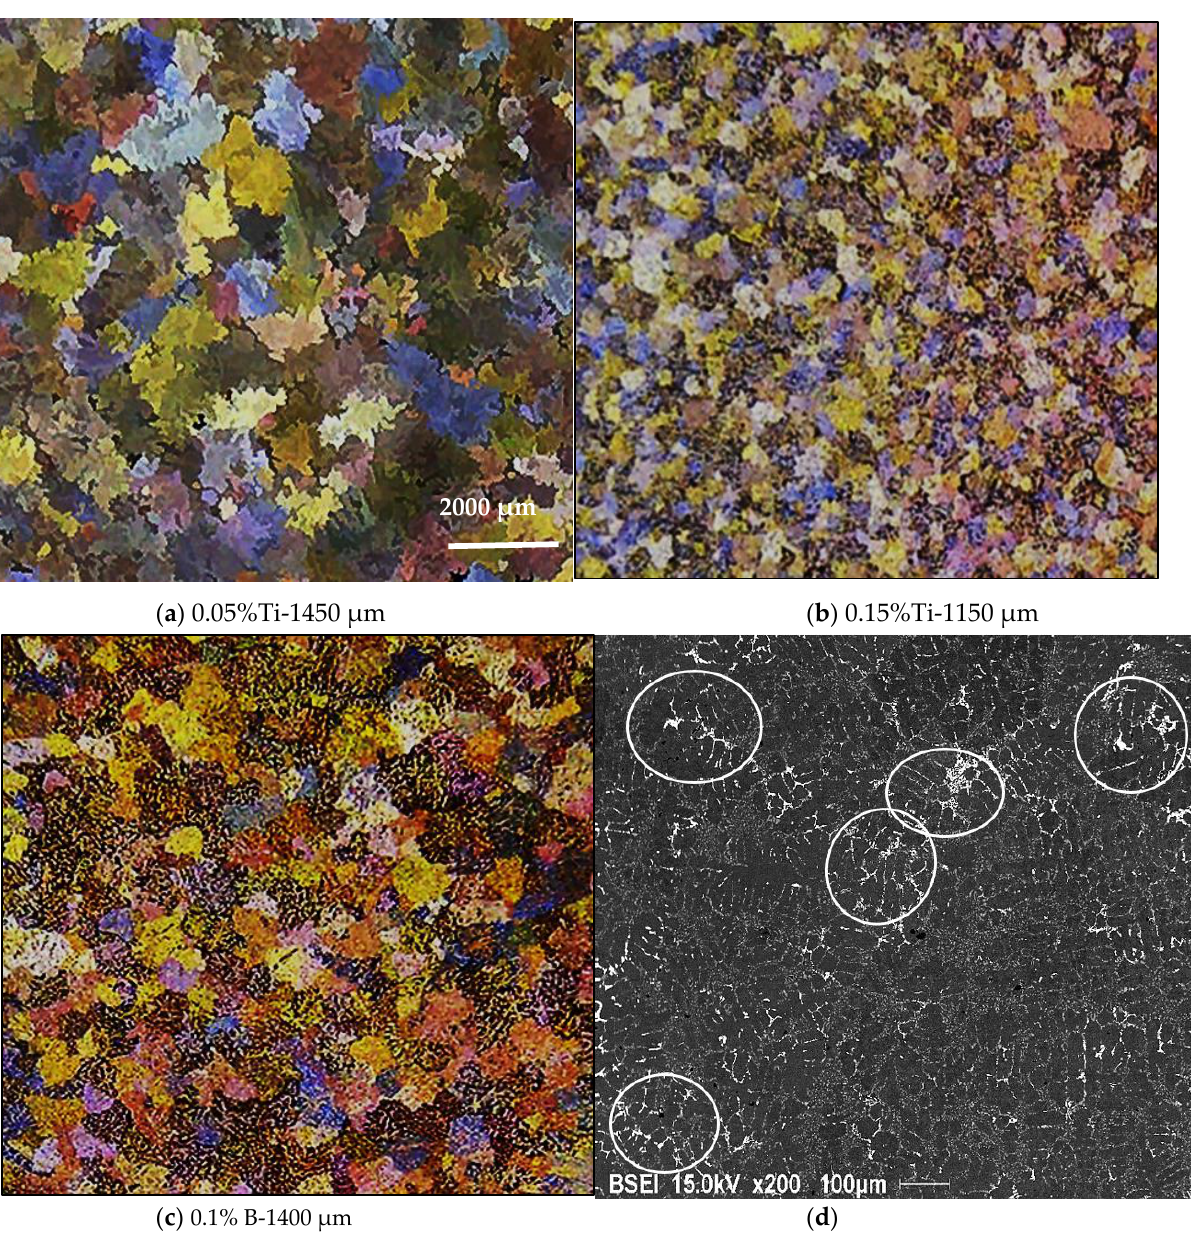
Figure 19. ( a,b ) Variation in the A390.1 alloy grain size as a function of the added ( a,b ) Ti, and ( c ) B content; ( d ) distribution of Al 2 Cu phase particles in the as-cast base alloy, see white circled areas.